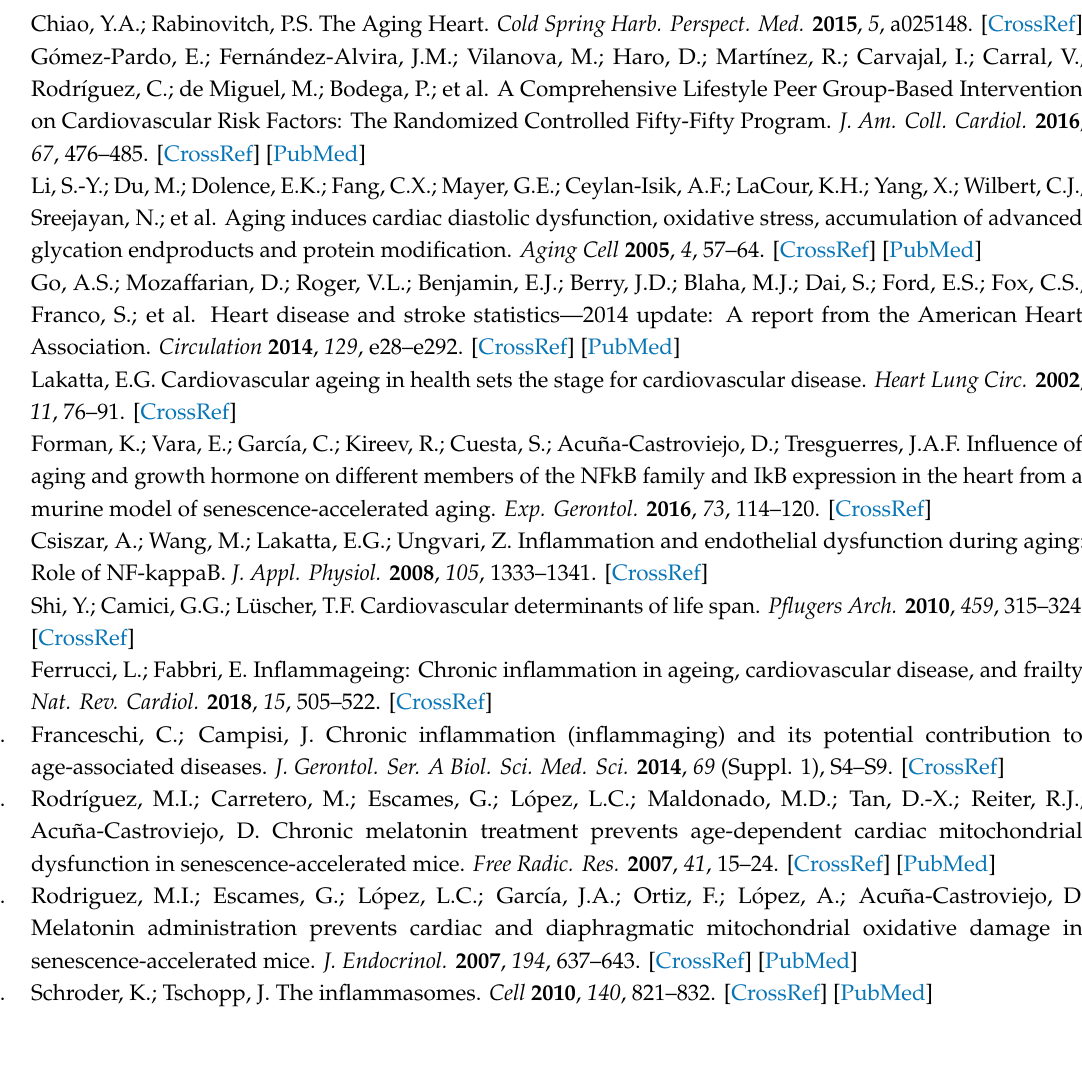
Figure S1: Full western blot data; Table S1: List of primary antibodies used in western blot